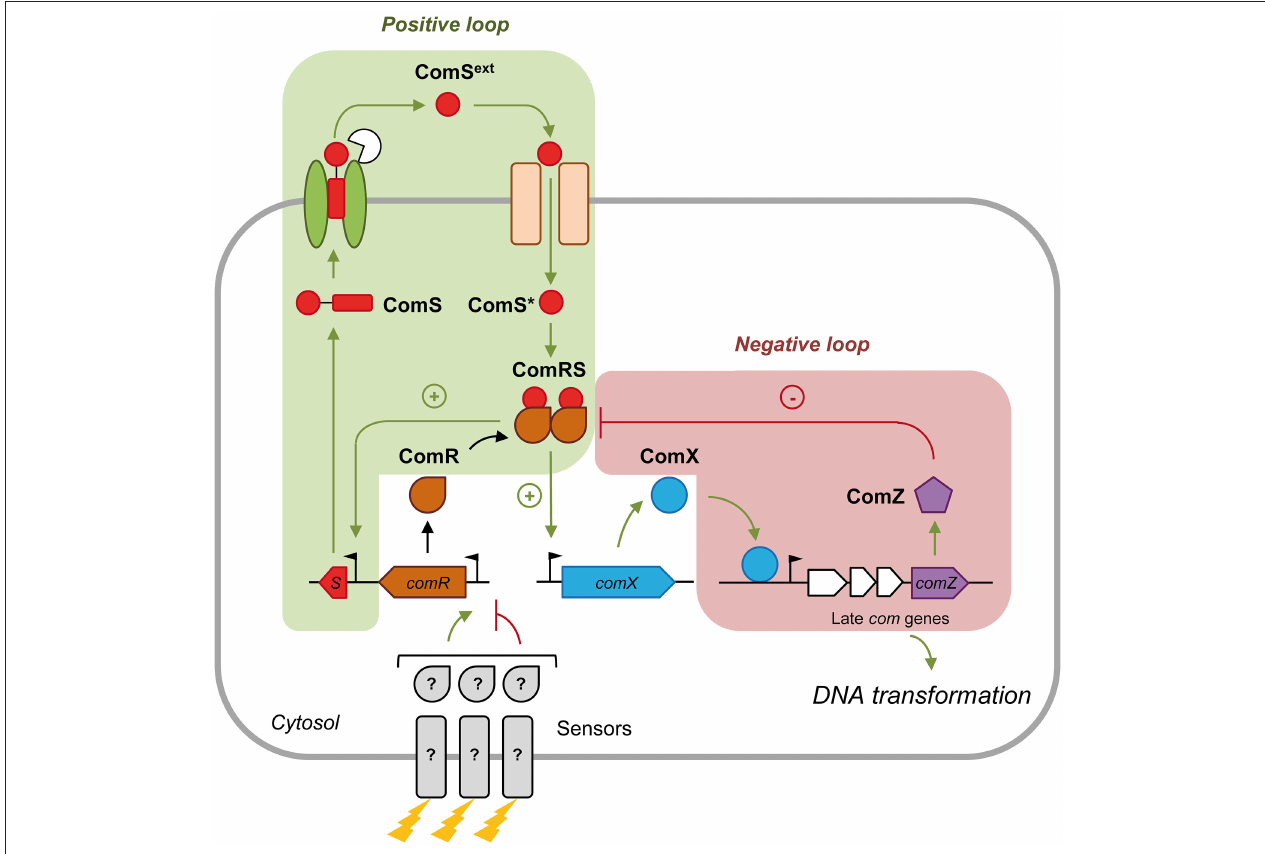
FIGURE 1 | Regulation of comX expression by the ComRS signal transduction system in streptococci. Competence development is initiated by the production of the precursor of the competence pheromone ComS. ComS is then exported by an unknown transporter and matured by species-specific protease(s). At a critical concentration, the mature competence peptide ComS ext (also named XIP) is sensed by a specific oligopeptide-binding protein OppA/AmiA and reimported through the Opp/Ami transporter. In the cytoplasm, the intracellular mature peptide ComS * interacts with the transcriptional regulator ComR. The resulting dimeric ComRS complex activates the transcription of early competence genes (green arrows) including comS (plus sign; positive feedback loop) and comX by binding to their promoter. Expression of comR is not activated by ComRS and is thought to be regulated by other regulators/sensors (?) in response to specific environmental cues (represented by lightning). ComX or σ X induces transcription of late competence genes necessary for DNA transformation. Competence shut-off (red lines) in S. thermophilus involves at least one or more late gene product(s), named here ComZ. ComZ is thought to interact with and inactivate the ComRS complex (minus sign; negative feedback loop). The names of modeled peptidic/proteic species in system S1 are in black